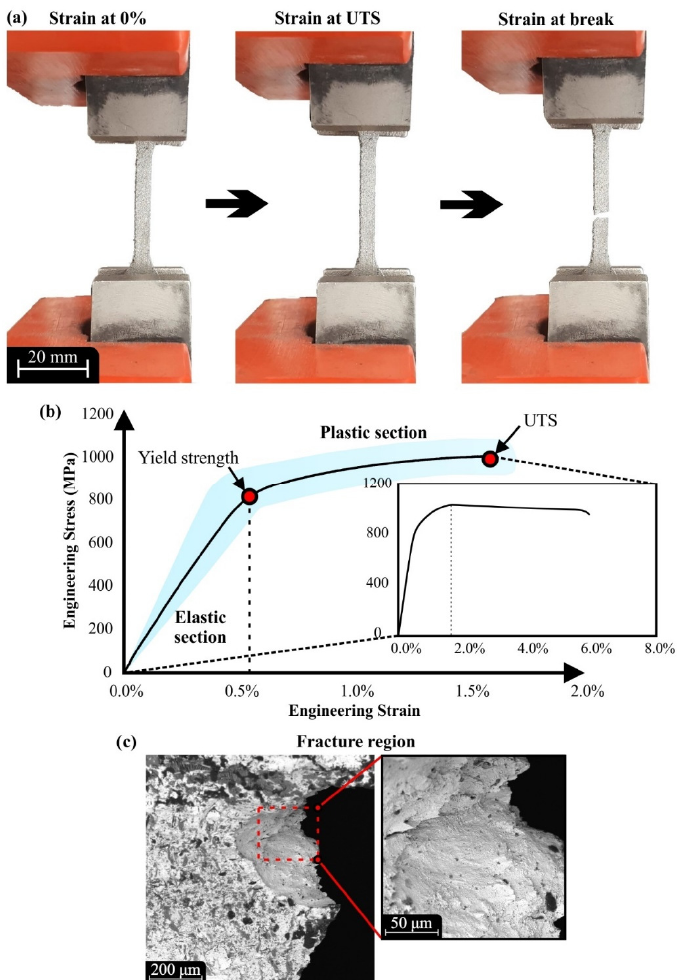
Figure 7. ( a ) Tensile loading at strain 0%, at peak stress, and at break; ( b ) stress–stain diagram for tensile loading for all test specimens (the shaded regions represent all the experimental data); ( c ) indicative SEM image from a fracture region.